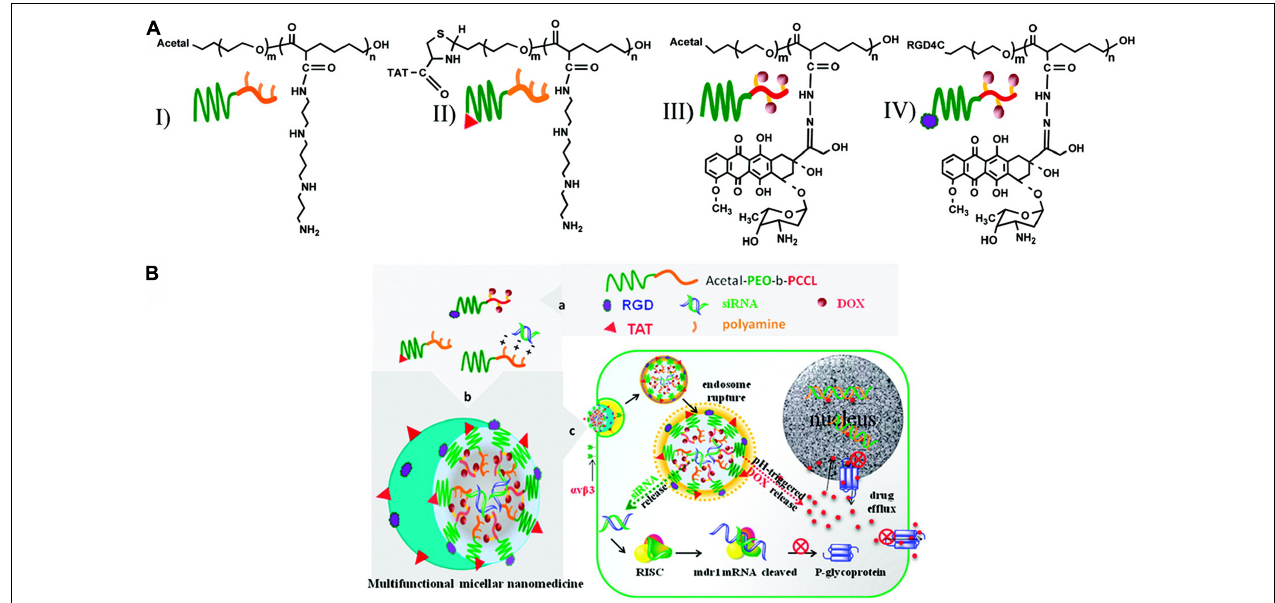
FIGURE 3 | Schematic representation of multifunctional micellar nanocarriers triggered by acidic pH. (A) Schematic illustration of acetal- and TAT-PEO-bP(CL-g-SP) (I and II) and acetal- and RGD4C-PEO-bP(CL-Hyd- DOX) (III and IV). (B) Rational design of a multifunctional micellar nanomedicine for cancer-targeted co-delivery of MDR-1 siRNA and DOX to overcome multidrug resistance. DOX release from NON-micelles triggered by acidic pH. Reprinted from Xiao-Bing Xiong and Afsaneh Lavasanifar. Traceable Multifunctional Micellar Nanocarriers for Cancer-Targeted Co-delivery of MDR-1 siRNA and Doxorubicin. ACS Nano. 2011;5(6):5202–13. With the permission of ACS publications/from reference (Xiong and Lavasanifar, 2011). MDR, multidrug resistance; PEO, poly(ethylene oxide); RGD, Arg-GLT-Asp (the integrin α v β 3-specific ligand); DOX, doxorubicin; TAT, trans-activating transcriptional activator.